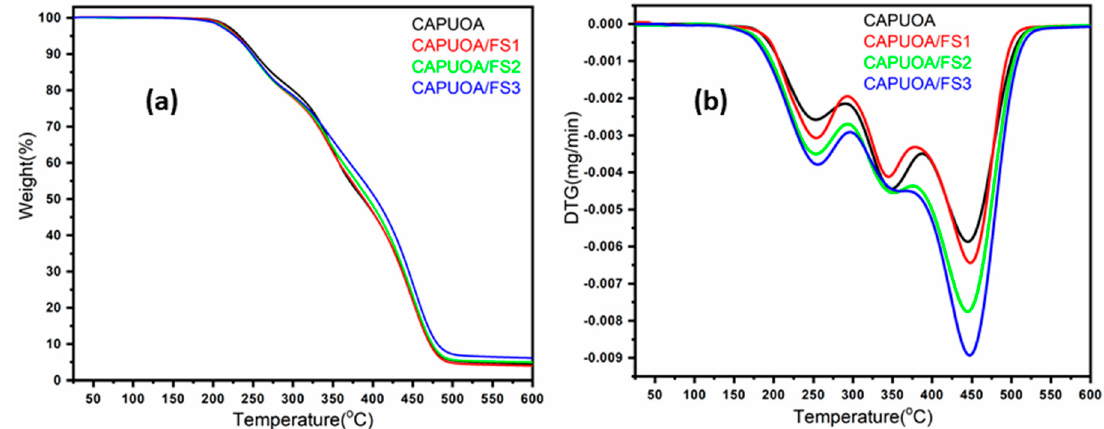
Figure 7. TGA ( a ) and DTG ( b ) thermogram of CAPUOA, CAPUOA/FS1, CAPUOA/FS2, and CAPUOA/FS3.